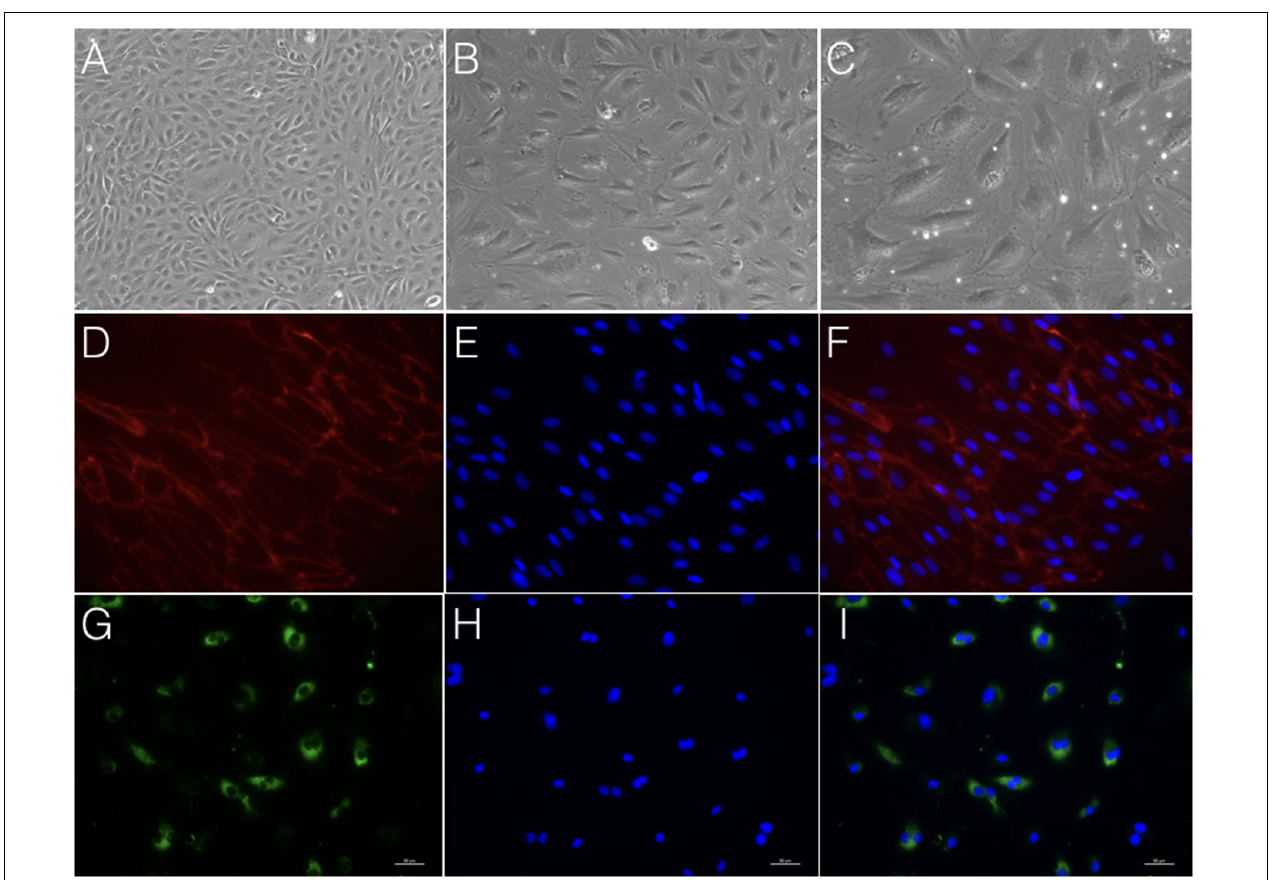
FIGURE 5 | Morphology and immunostaining of cAVM-ECs. (A–C) morphology of cAVM-ECs in different fields of view; (A) scale bar = 100 µ m; (B) scale bar = 50 µ m; (C) scale bar = 20 µ m; (D) CD31 expression; (E) 4 (cid:48) , 6-diamidino-2-phenylindole (DAPI) staining; (F) Merge, scale bar = 50 µ m; (G) CD34 expression; (H) DAPI staining; (I) Merge, scale bar = 50 µ m.